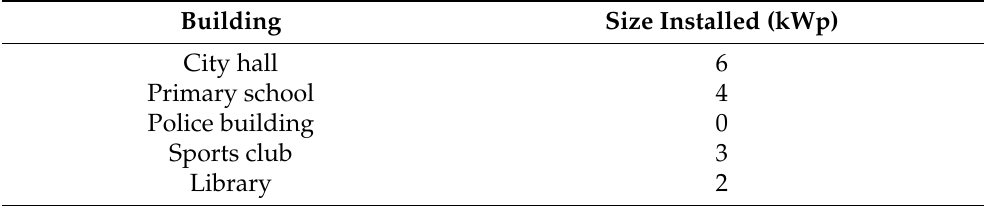
Table 1. Current nominal power of photovoltaic (PV) generation per each building taken in